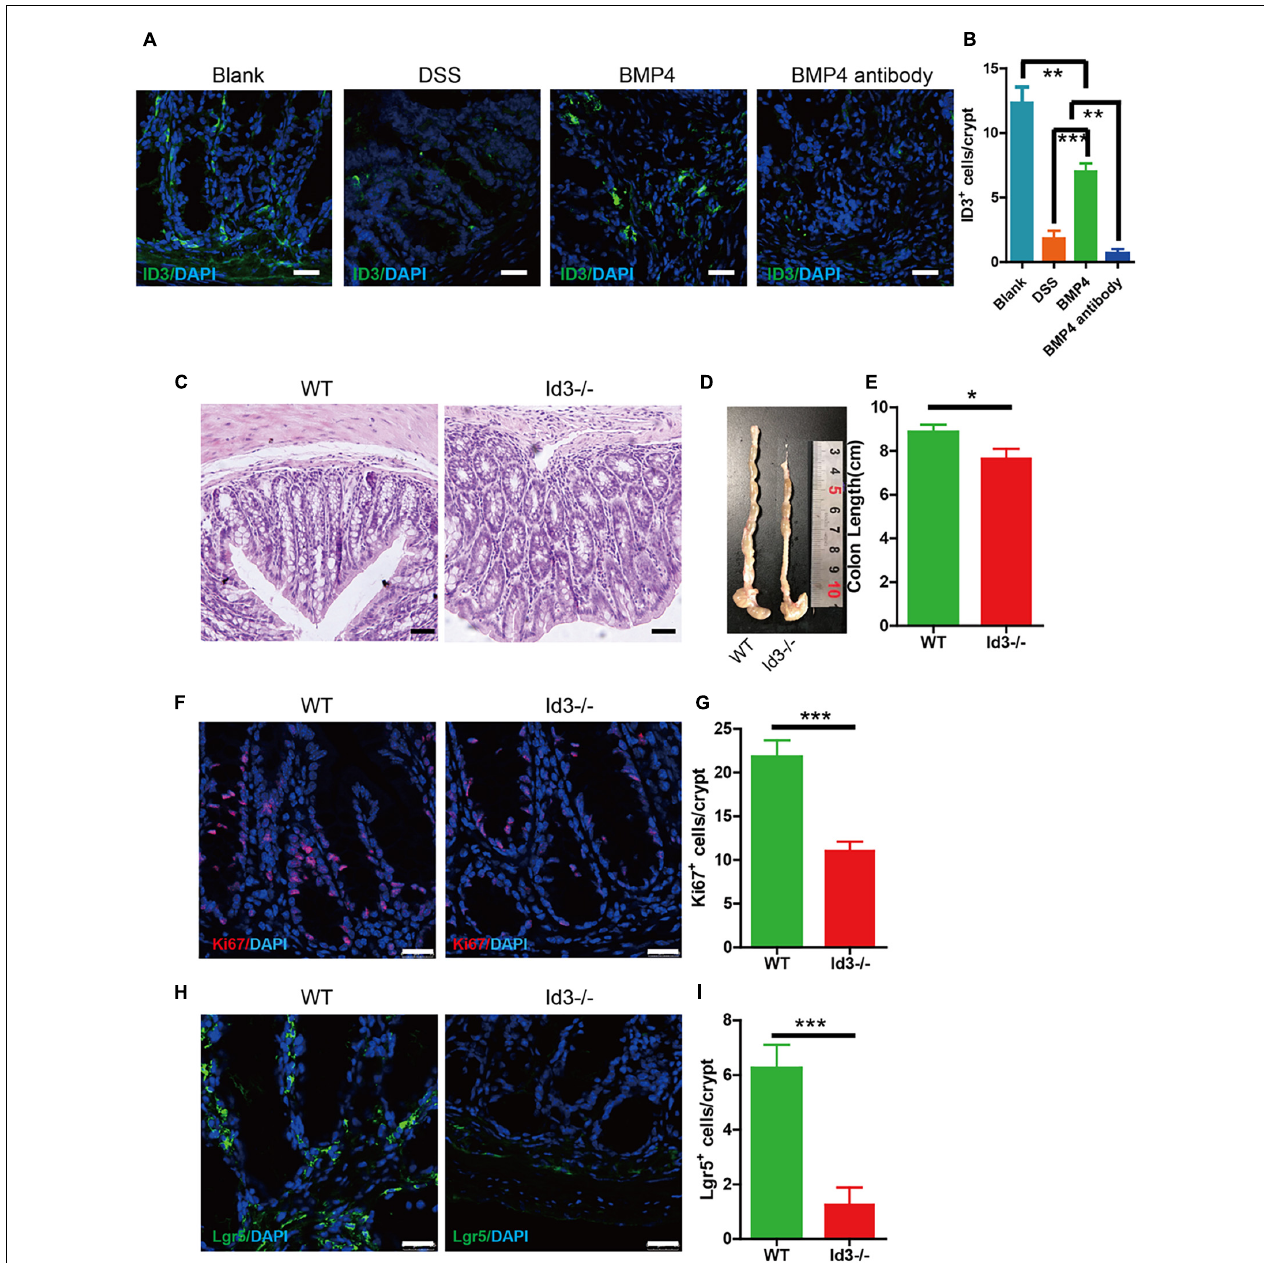
FIGURE 6 | BMP4 ameliorated DSS-induced colitis by target ID3. (A) Immunofluorescence staining for ID3 expression in blank mice, DSS-induced mice treated with saline, BMP4, or anti-BMP4 antibody (green: ID3, blue: DAPI). (B) Quantification of ID3-positive cells per crypt from the colon. (C) Sections of colon tissues stained with H&E from Id3 − / − aged mice and wild-type aged mice. (D,E) Colon length from Id3 − / − aged mice and wild-type aged mice. (F) Immunofluorescence staining of Ki67 in colon tissue from Id3 − / − aged mice and wild-type aged mice. (G) Quantification of Ki67-positive cells per crypt from Id3 − / − aged mice and wild-type aged mice. (H) Immunofluorescence labeling shows the Lgr5-positive cells in tissue from Id3 − / − aged mice and wild-type aged mice. (I) Quantification of Lgr5-positive cells per crypt from Id3 − / − aged mice and wild-type aged mice. Data represent mean ± SD; one-way ANOVA and Bonferroni tests for multiple testing. Student t -test was used for data analyses from Id3 − / − aged mice and wild-type aged mice. * p < 0.05, ** p < 0.01, *** p < 0.001. Scale bar = 25 µ